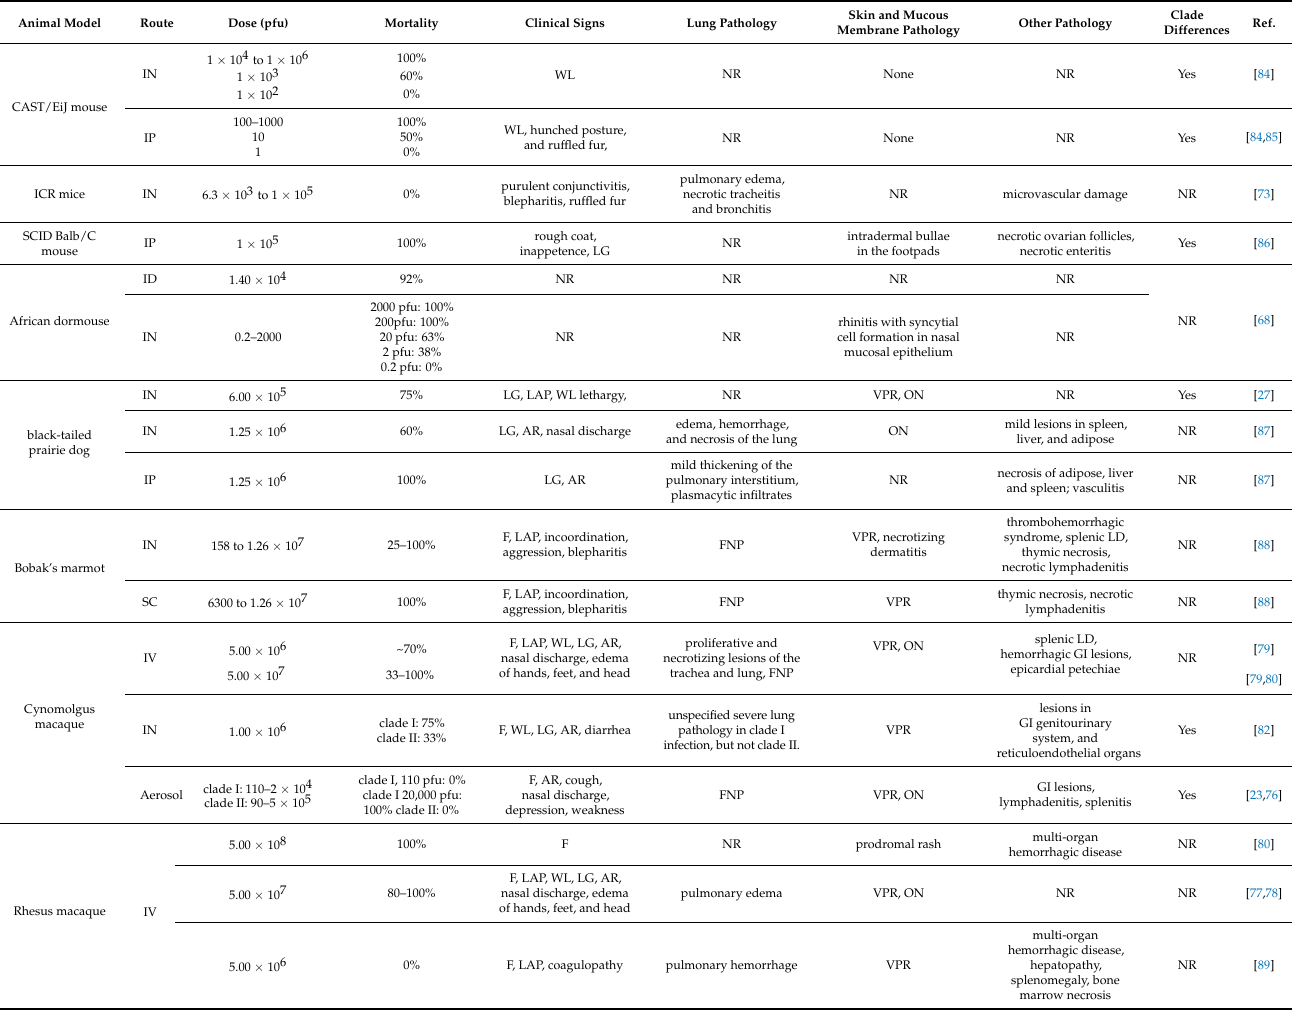
Table 1. Outcomes of infection in animal models used for the study of mpox, by species, dose, and route of infection, including intranasal (IN), intraperitoneal (IP), intradermal (ID), subcutaneous (SC), and intravenous (IV). Mortality ClinicalSigns LungPathology SkinandMucous MembranePathology OtherPathology Clade Differences